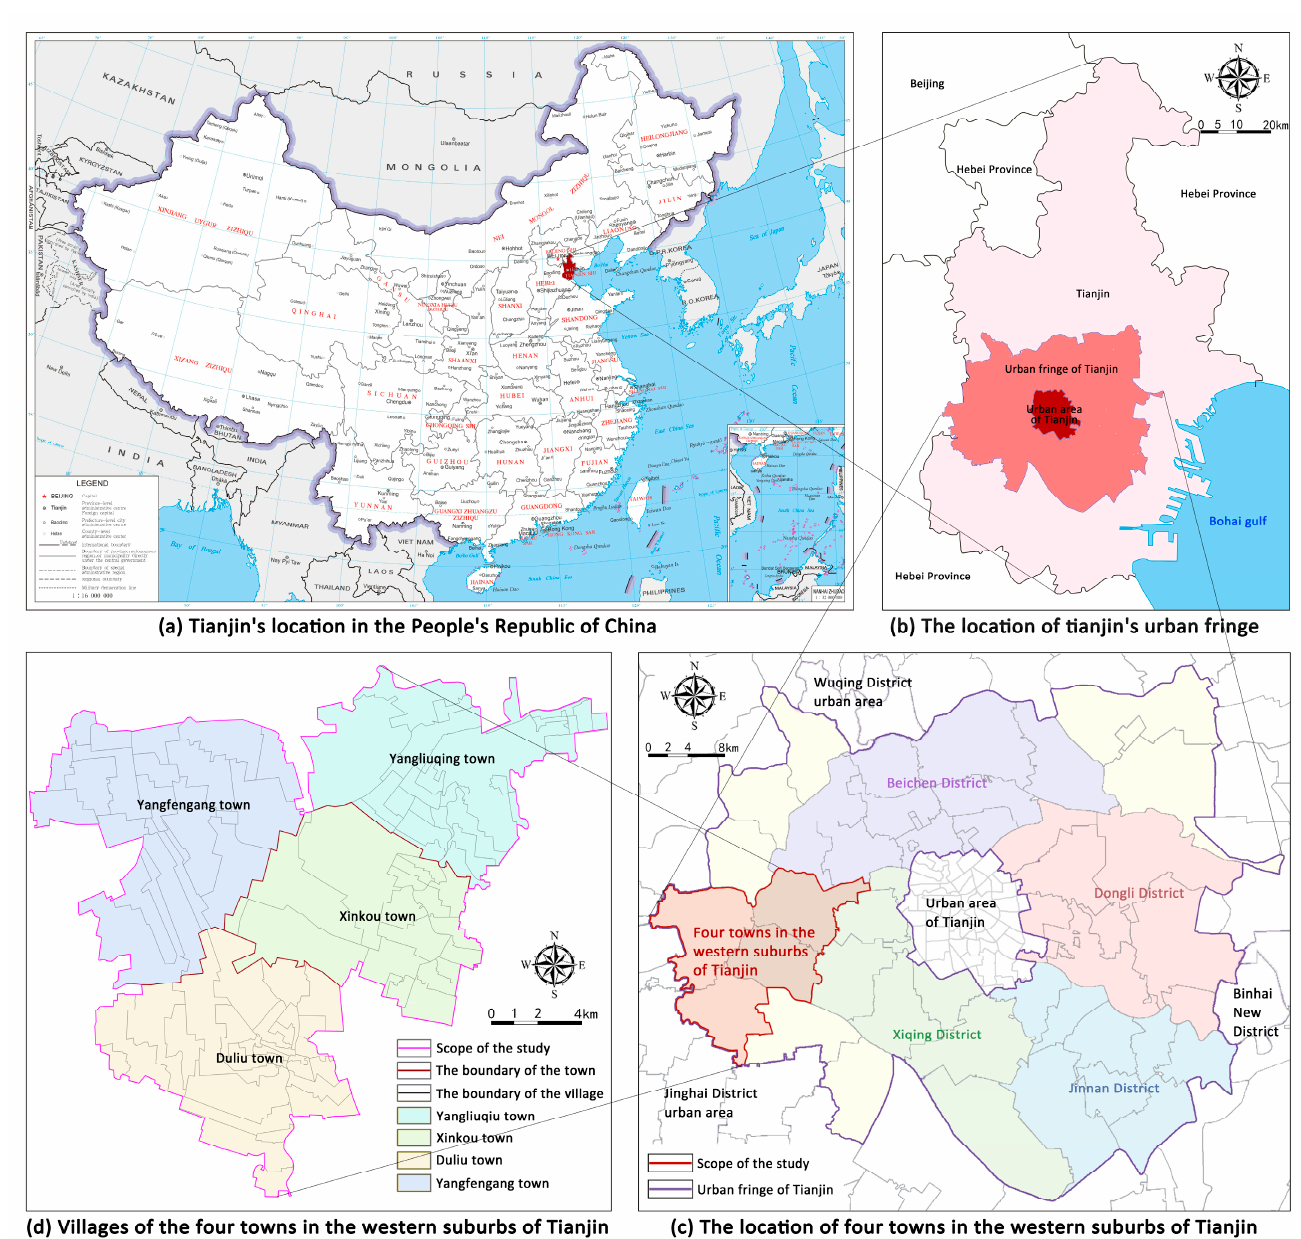
Figure 1. Location of the research area. ( a ) The location of Tianjin in China, ( b ) the extent of the suburbs of Tianjin, ( c ) the extent of the four towns in the western suburbs of Tianjin, and ( d ) the administrative boundaries of the 93 villages in the western suburbs of Tianjin (source: self-drawn).